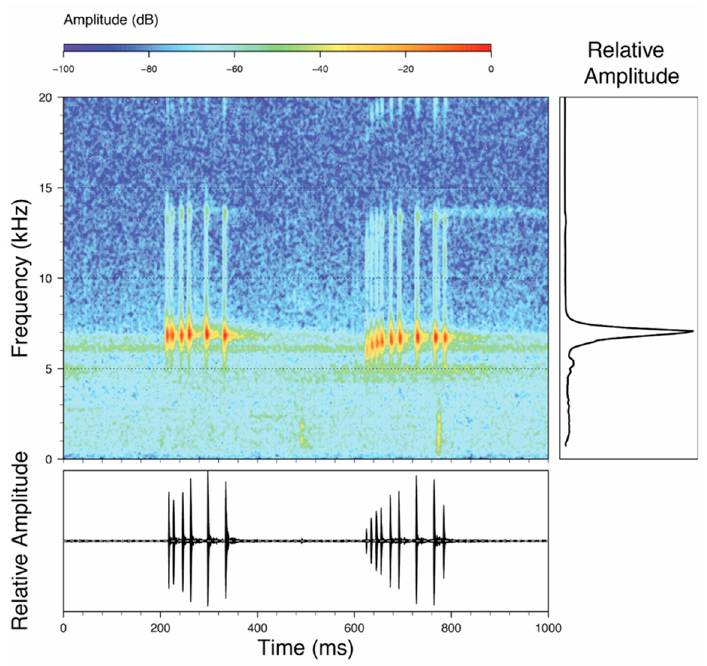
Figure 220. Call of Teratohyla spinosa , LBE-C-002, recorded at Reserva Otokiki, 706 m, Esmeraldas province, Ecuador.